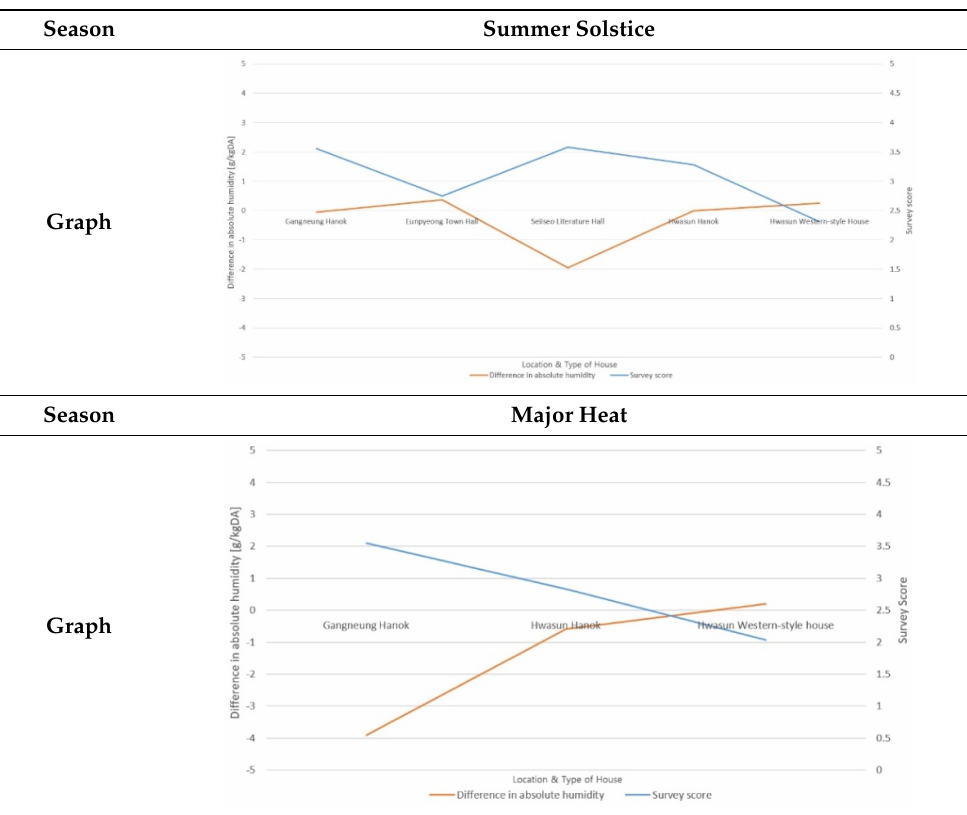
Table 5. Comparison between the absolute humidity difference and survey